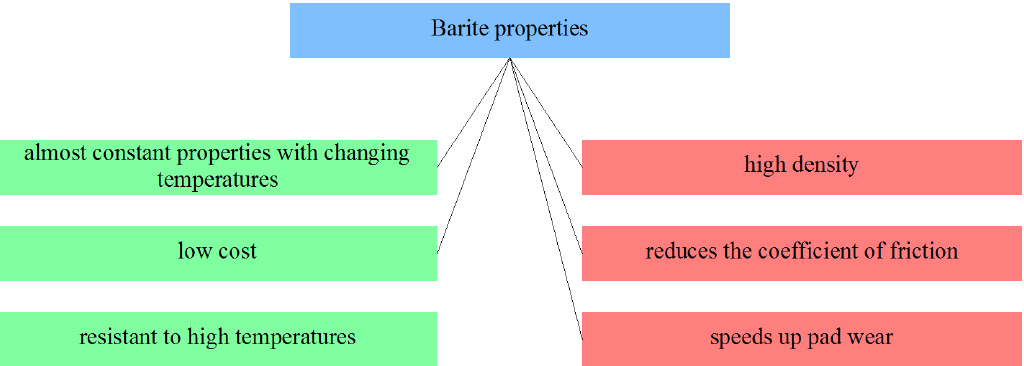
Figure 18: Selected barite composites properties from the point of view of applicability in friction